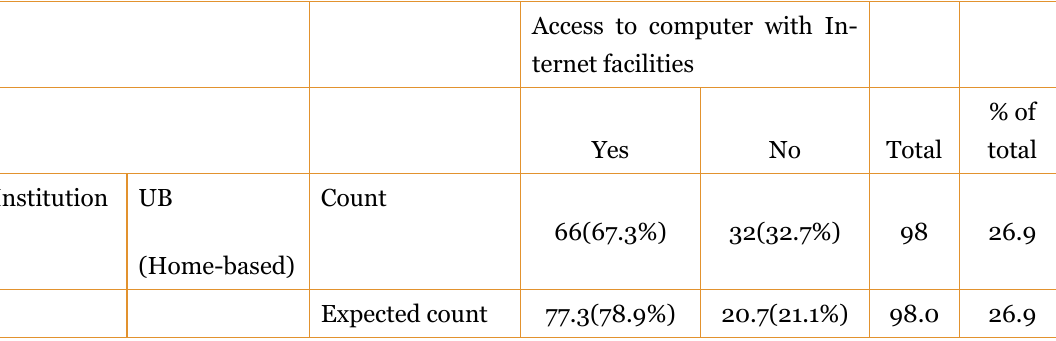
Institution and Access to Computer with Internet facilities